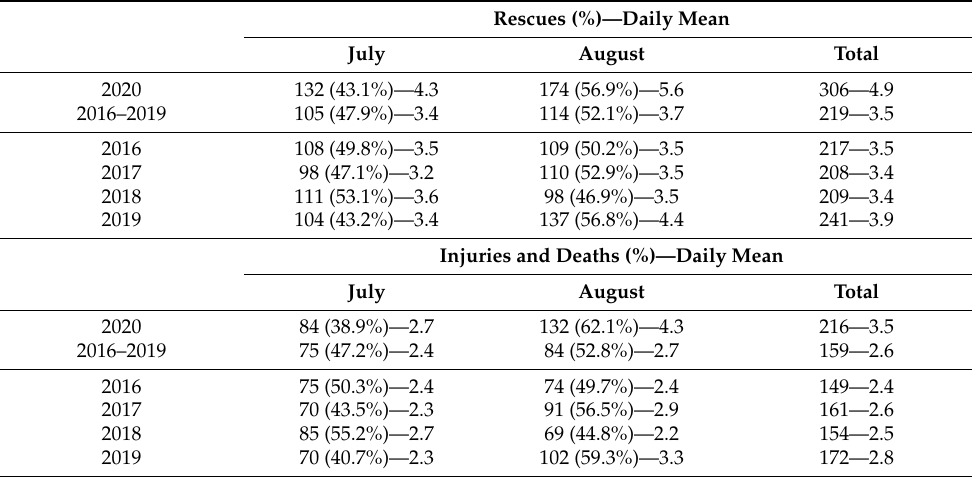
Table 2. Frequency and daily mean number of rescues and